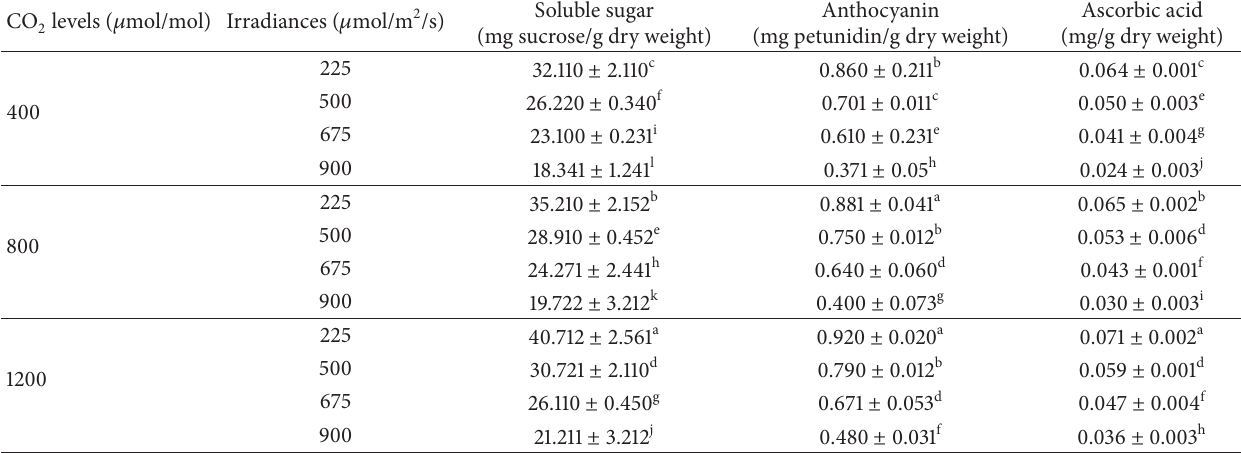
Table 3: Interaction effects of CO levels and irradiance on leaf total phenolics and total flavonoids production in Labisia pumila 2